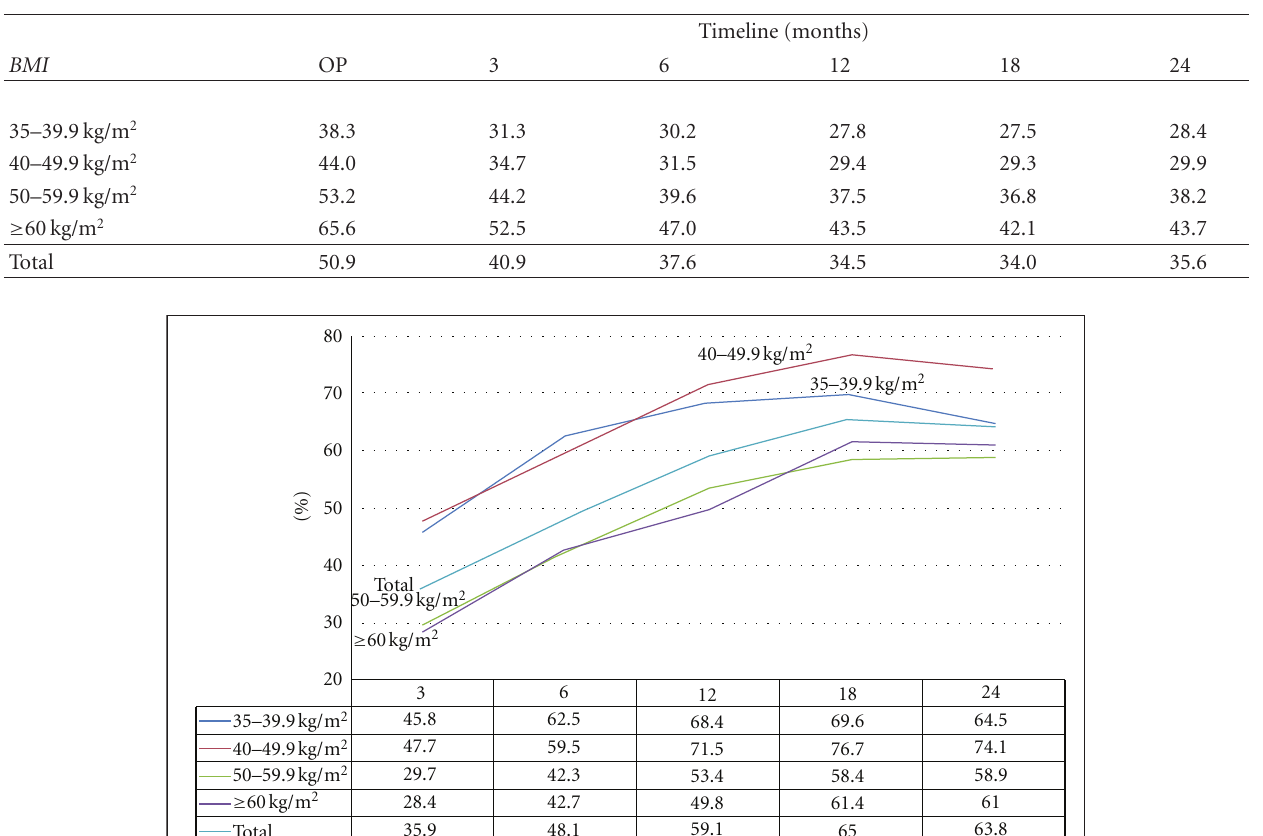
Table 5: Weight progression (BMI in kg/m 2 ) of patients without a second operation during the follow-up period ( n = 57).